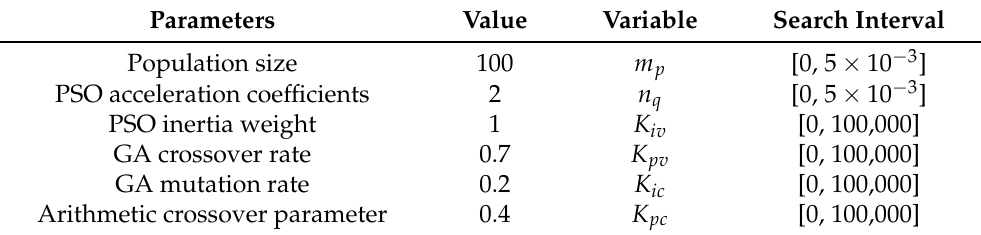
Table 3. The optimization techniques parameters and search interval of variables.